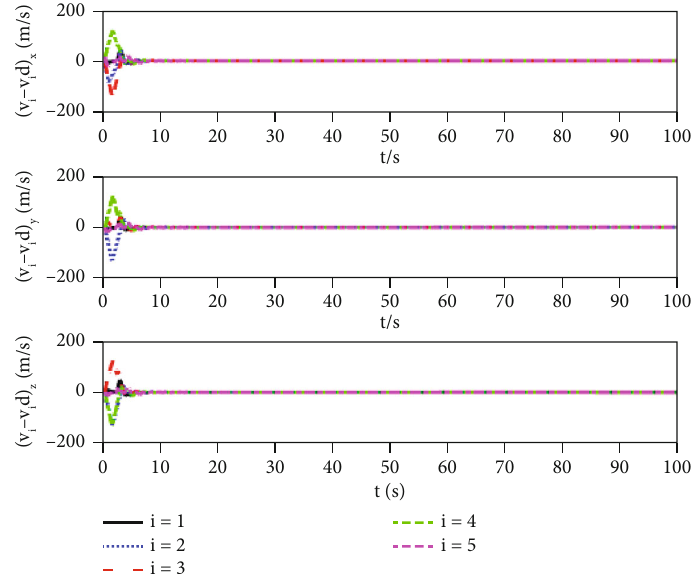
Figure 4: Missile velocity tracking error.